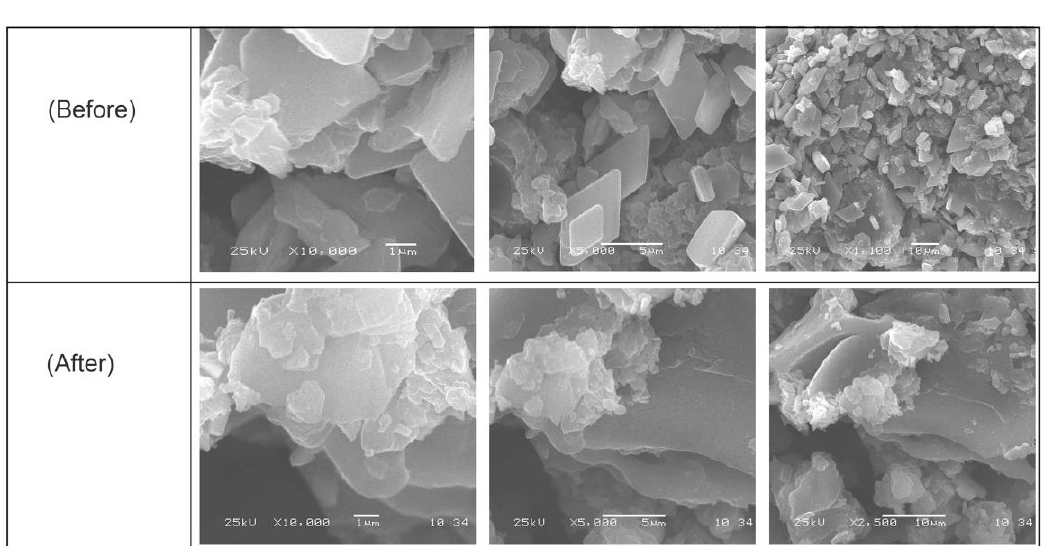
Figure 4. SEM micrograph for GO-date Seeds before and after adsorption.